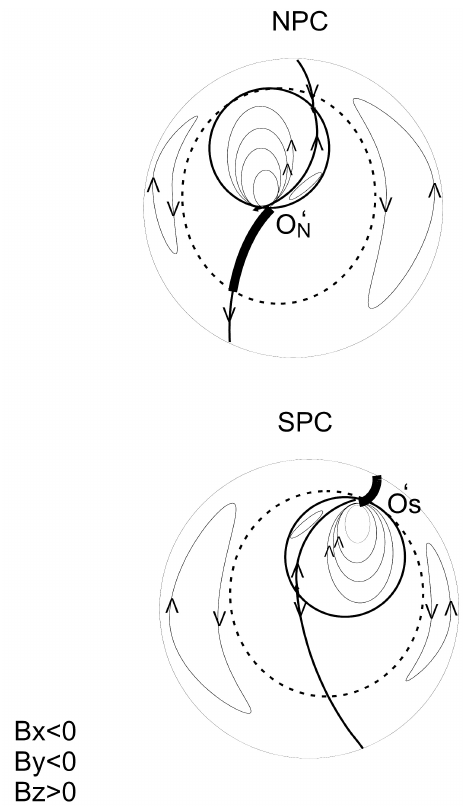
Fig. 7. Ionospheric convection patterns in the northern and South- ern Hemispheres. Thick curves mark the location of magnetic field lines that come close to the separator line C 1 C 2 . Northward IMF with B x < 0, B y <